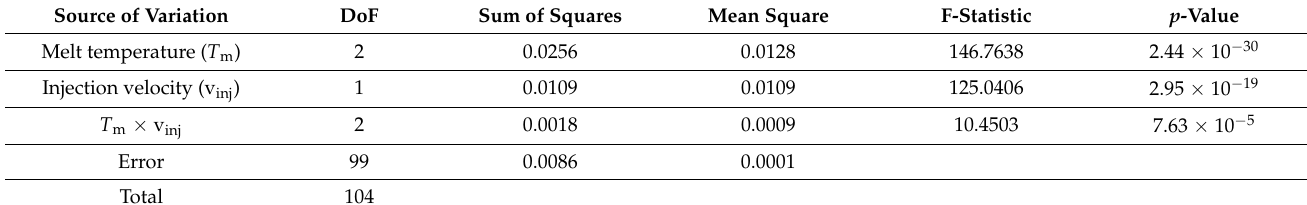
Table A2. Analysis of the main effects and interactions for the right side of the